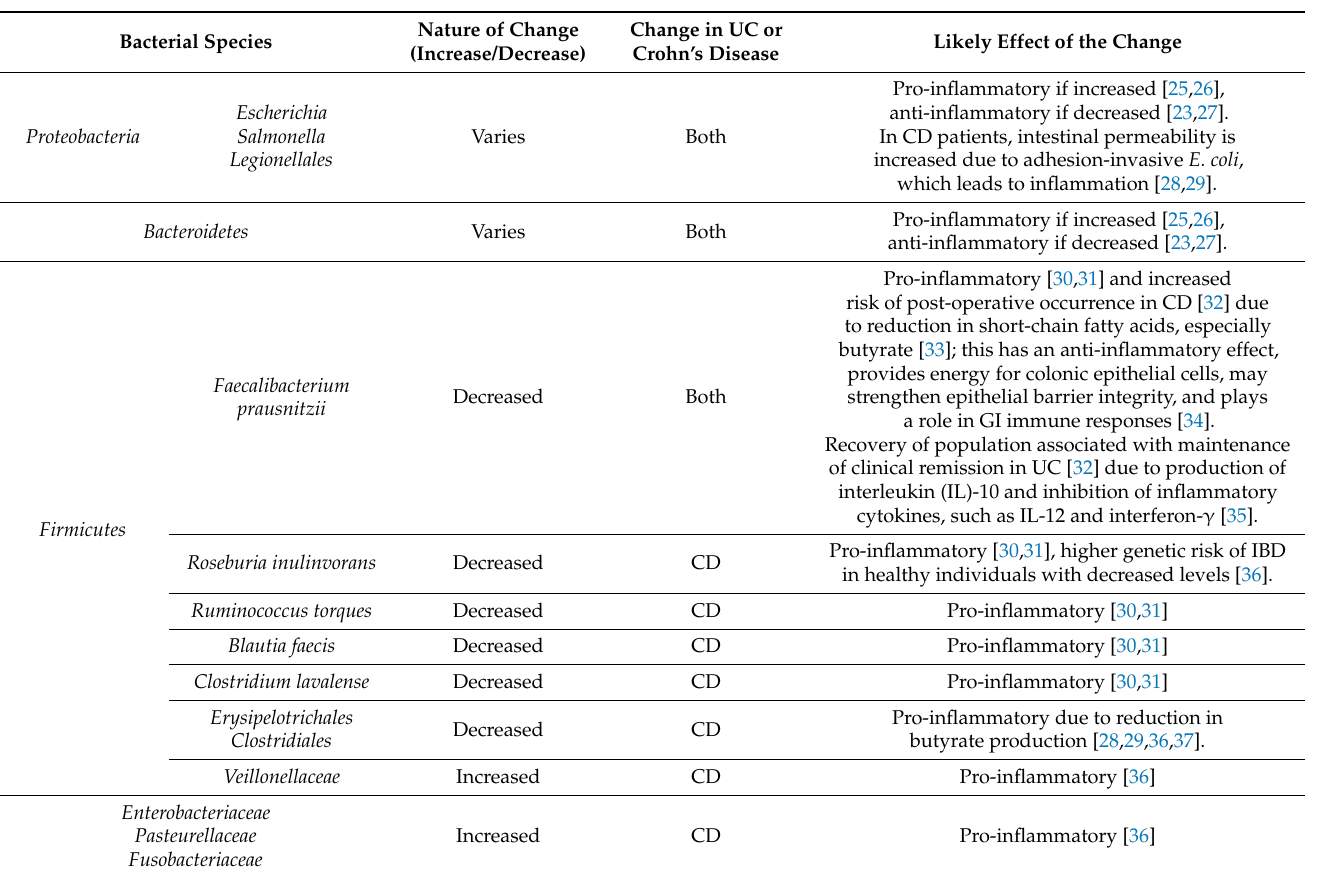
Table 1. Summarising the changes in bacterial population in IBD and the likely effect of the